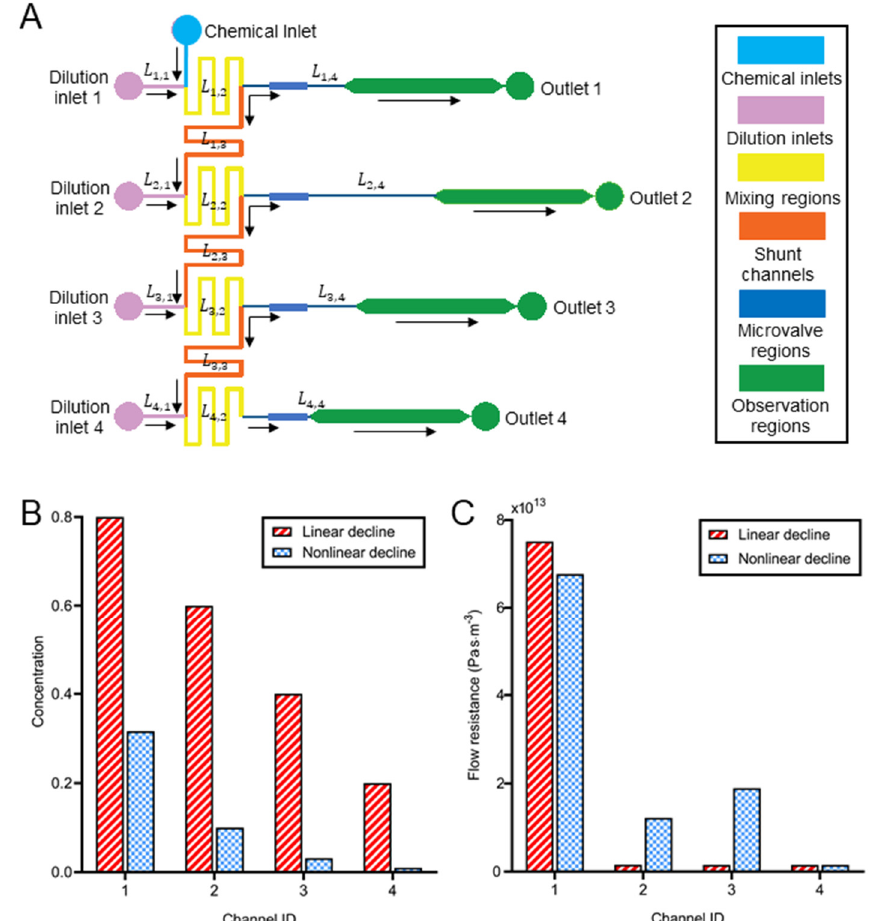
Figure 2. The calculation of the flow resistance for the dynamic concentration generation. ( A ) The schematic of the microchannel network in the flow layer. ( B ) The designed concentration in four parallel channels if the concentration at the chemical inlet was 1 (n = 4). The concentration in each channel was normalized to that in the first channel. ( C ) The flow resistance in the valve regions to acquire the concentration ratios in Figure ( B ).